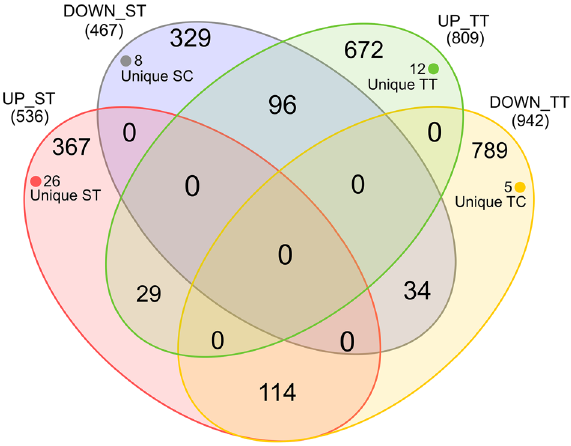
Figure 2. Venn diagram of DEGs under Al stress ( UP_TT up-regulated genes in Al resistant line, DOWN_TT down-regulated genes in Al resistant line, UP_ST up-regulated genes expressed in Al-sensitive line, DOWN_ST down-regulated genes expressed in Al-sensitive